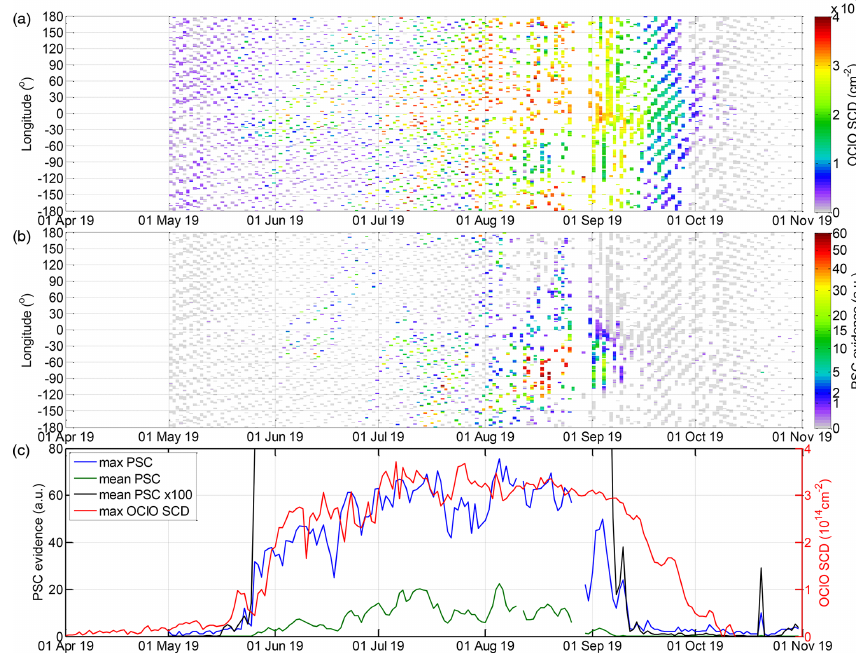
Figure 15. Same as Fig. 3 but for the Antarctic winter